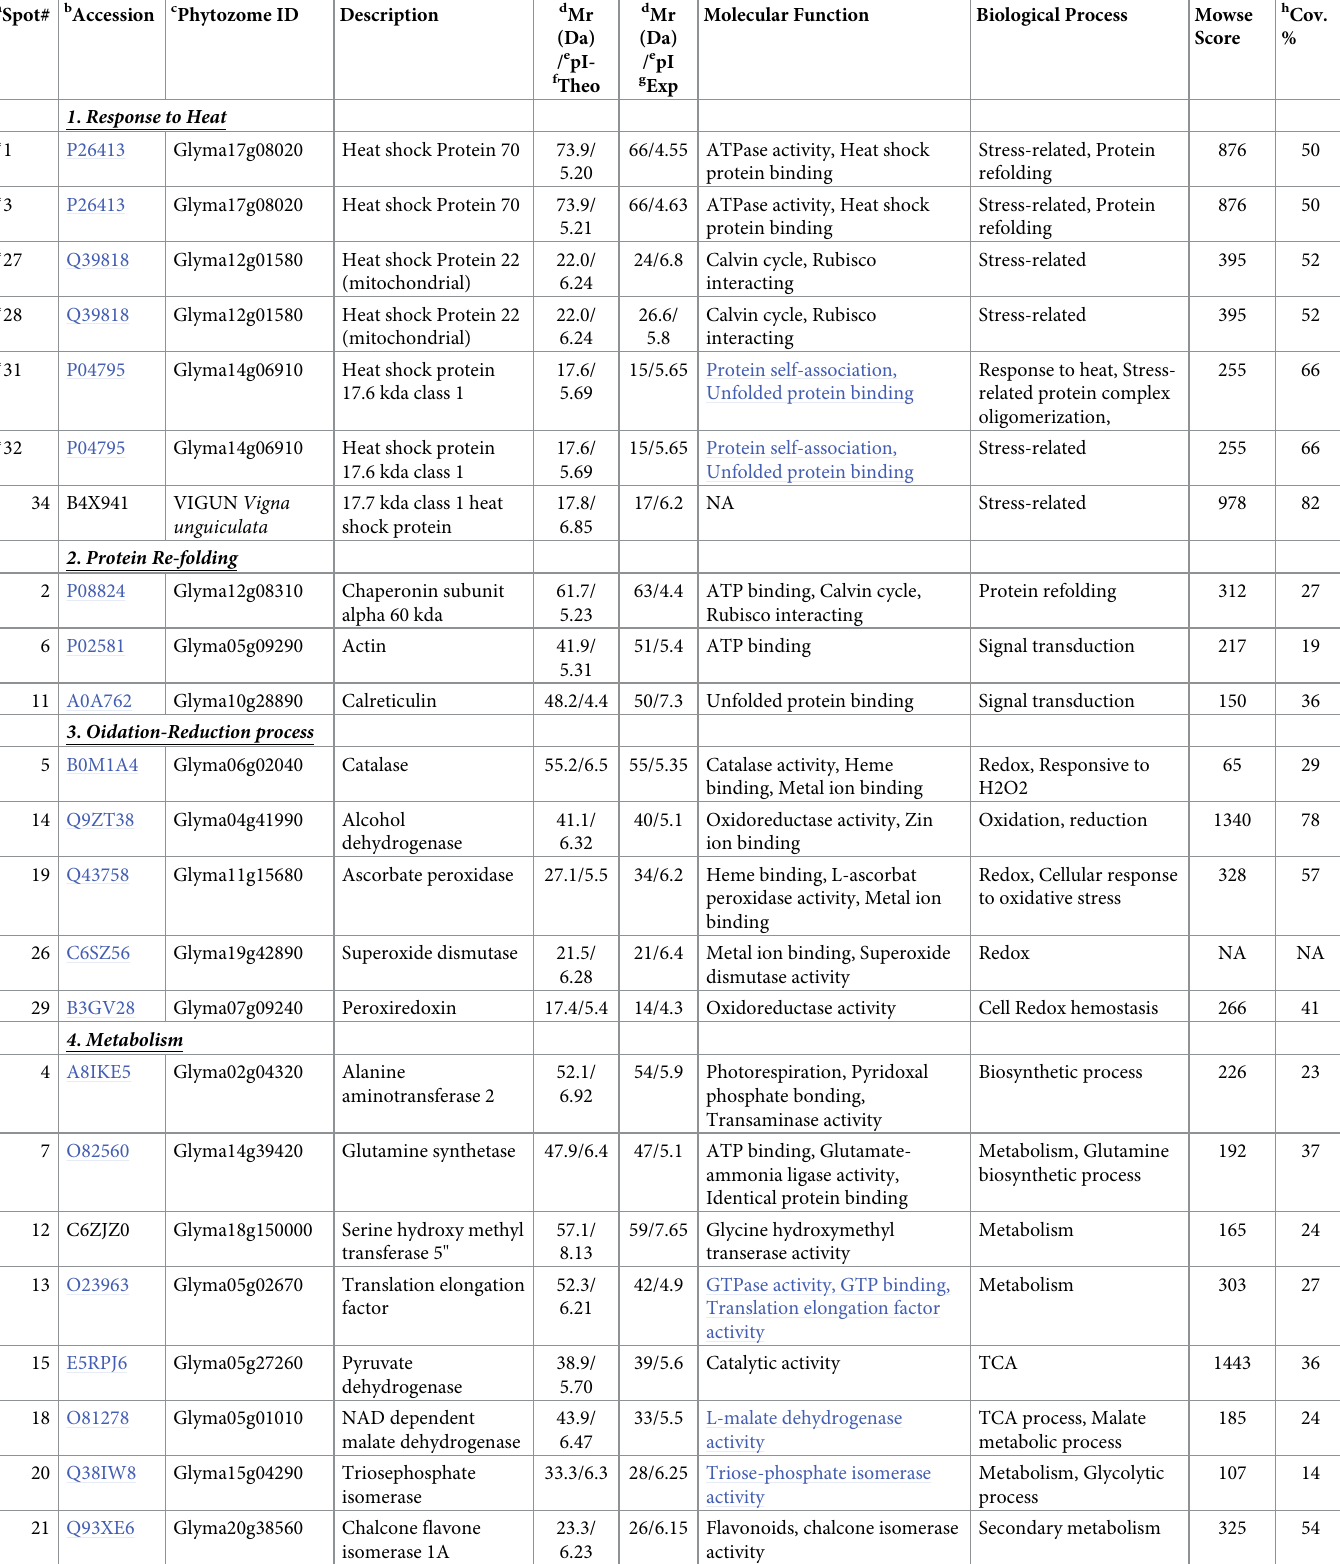
Table 2. Identification of relatively abundant stress responsive proteins in soybean leaf